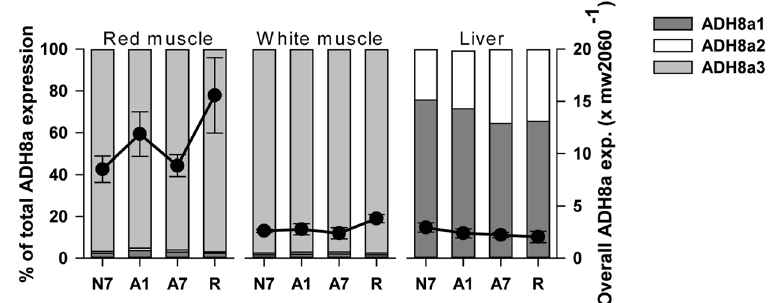
Figure 4. ADH8a transcript levels in red muscle, white muscle and liver of crucian carp. mRNA expression levels of ADH8a1–3 normalized to expression of mw2060 in red muscle, white muscle and liver of crucian carp. X axes show treatment groups (N7, A1, A7 and R). Left y-axes and bars show percentage distribution of paralogs, while right y-axes and filled circles show overall expression levels of genes (means ± S.E.M. of all paralogs combined; n = 6–8 fish per group). No statistical differences between groups compared to N7 were found (One-way